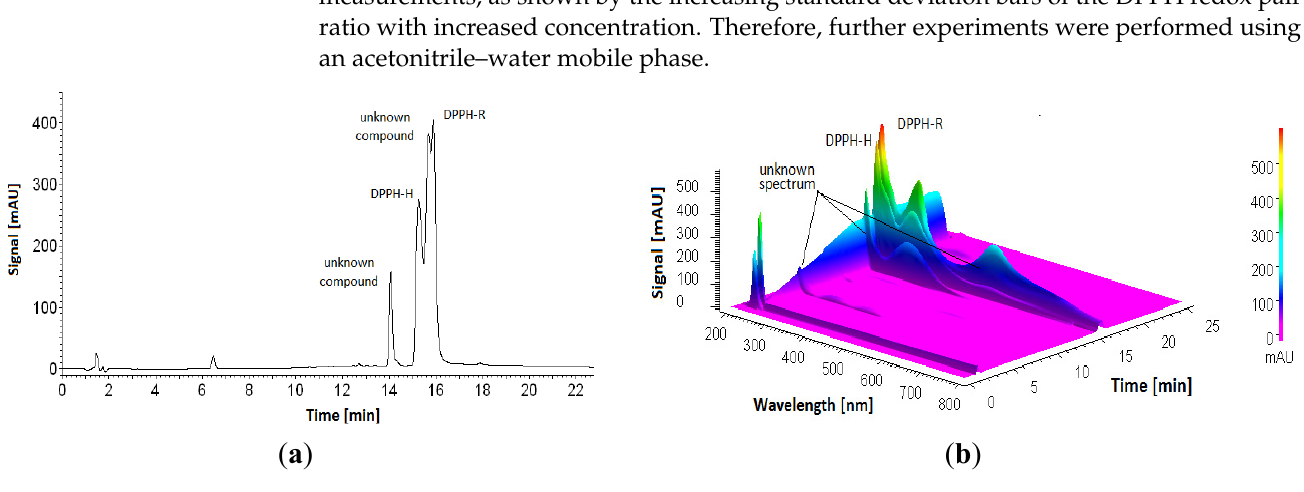
Figure 5. Chromatogram (2D ( a ) and 3D ( b )) of 1 mM DPPH ( a ) obtained by gradient elution staring from 30% ACN/water with the addition of acetic acid within 20 min (pH = 3.5). The detection wavelength was set at 330 nm.